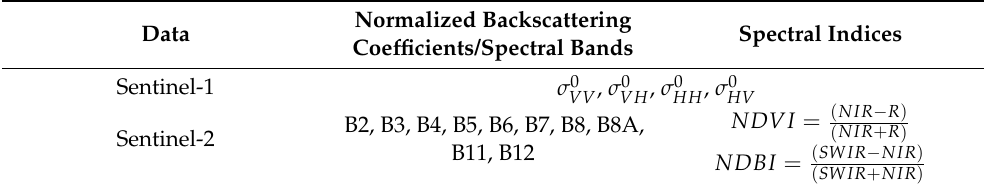
Table 2. The normalized backscattering coefficients, spectral bands, and indices used in this study ( NDVI = normalized difference vegetation index, NDBI = normalized difference build-up